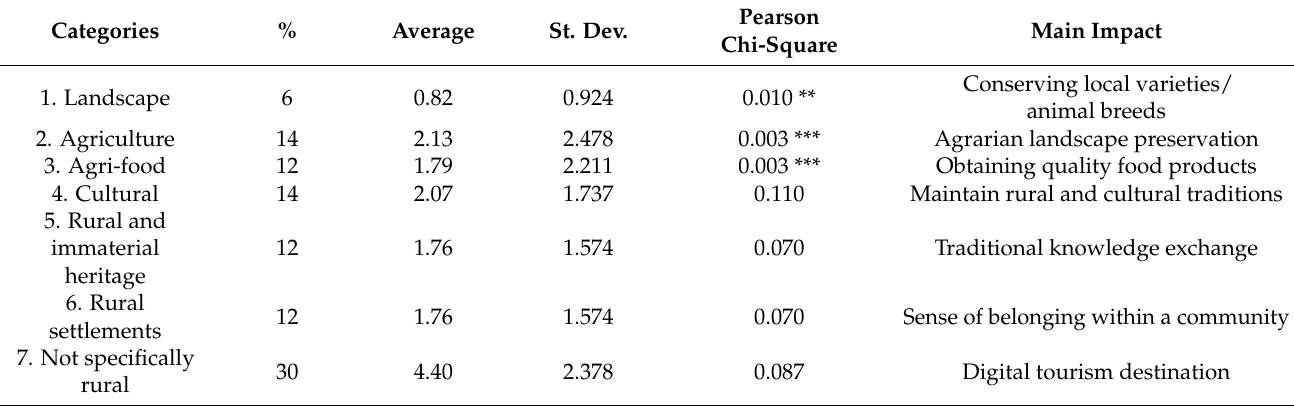
Table 7. Main resources based on agritourism